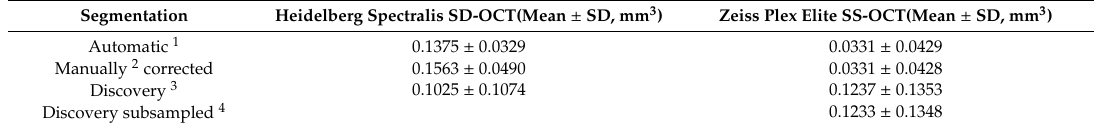
Table 1. Mean measurements for central 1 and 3 mm ETDRS circle drusen volume.